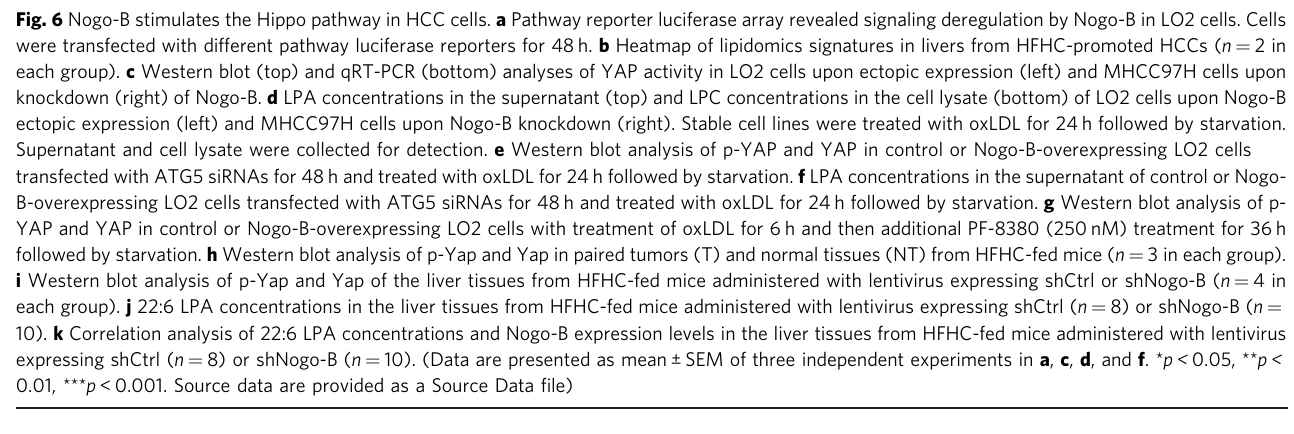
Fig. 6 Nogo-B stimulates the Hippo pathway in HCC cells. a Pathway reporter luciferase array revealed signaling deregulation by Nogo-B in LO2 cells. Cells were transfected with different pathway luciferase reporters for 48 h. b Heatmap of lipidomics signatures in livers from HFHC-promoted HCCs ( n = 2 in each group). c Western blot (top) and qRT-PCR (bottom) analyses of YAP activity in LO2 cells upon ectopic expression (left) and MHCC97H cells upon knockdown (right) of Nogo-B. d LPA concentrations in the supernatant (top) and LPC concentrations in the cell lysate (bottom) of LO2 cells upon Nogo-B ectopic expression (left) and MHCC97H cells upon Nogo-B knockdown (right). Stable cell lines were treated with oxLDL for 24 h followed by starvation. Supernatant and cell lysate were collected for detection. e Western blot analysis of p-YAP and YAP in control or Nogo-B-overexpressing LO2 cells transfected with ATG5 siRNAs for 48 h and treated with oxLDL for 24 h followed by starvation. f LPA concentrations in the supernatant of control or Nogo- B-overexpressing LO2 cells transfected with ATG5 siRNAs for 48 h and treated with oxLDL for 24 h followed by starvation. g Western blot analysis of p- YAP and YAP in control or Nogo-B-overexpressing LO2 cells with treatment of oxLDL for 6 h and then additional PF-8380 (250 nM) treatment for 36 h followed by starvation. h Western blot analysis of p-Yap and Yap in paired tumors (T) and normal tissues (NT) from HFHC-fed mice ( n = 3 in each group). i Western blot analysis of p-Yap and Yap of the liver tissues from HFHC-fed mice administered with lentivirus expressing shCtrl or shNogo-B ( n = 4 in each group). j 22:6 LPA concentrations in the liver tissues from HFHC-fed mice administered with lentivirus expressing shCtrl ( n = 8) or shNogo-B ( n = 10). k Correlation analysis of 22:6 LPA concentrations and Nogo-B expression levels in the liver tissues from HFHC-fed mice administered with lentivirus expressing shCtrl ( n = 8) or shNogo-B ( n = 10). (Data are presented as mean ± SEM of three independent experiments in a , c , d , and f . * p < 0.05, ** p